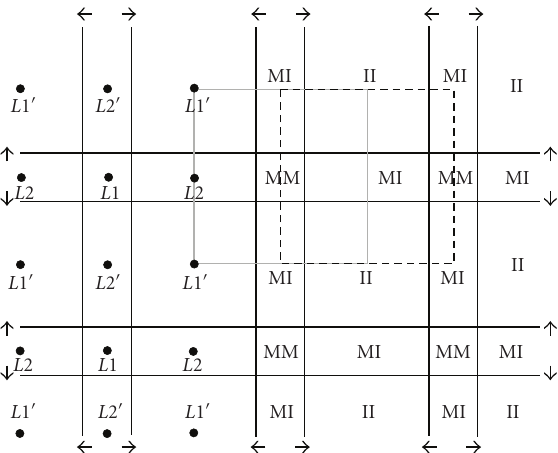
Figure 15: Schematic front view of the periodic triple point line structure. The gray square shows the situation of (a) of Figure 14; the black dotted square corresponds to (b) at the same